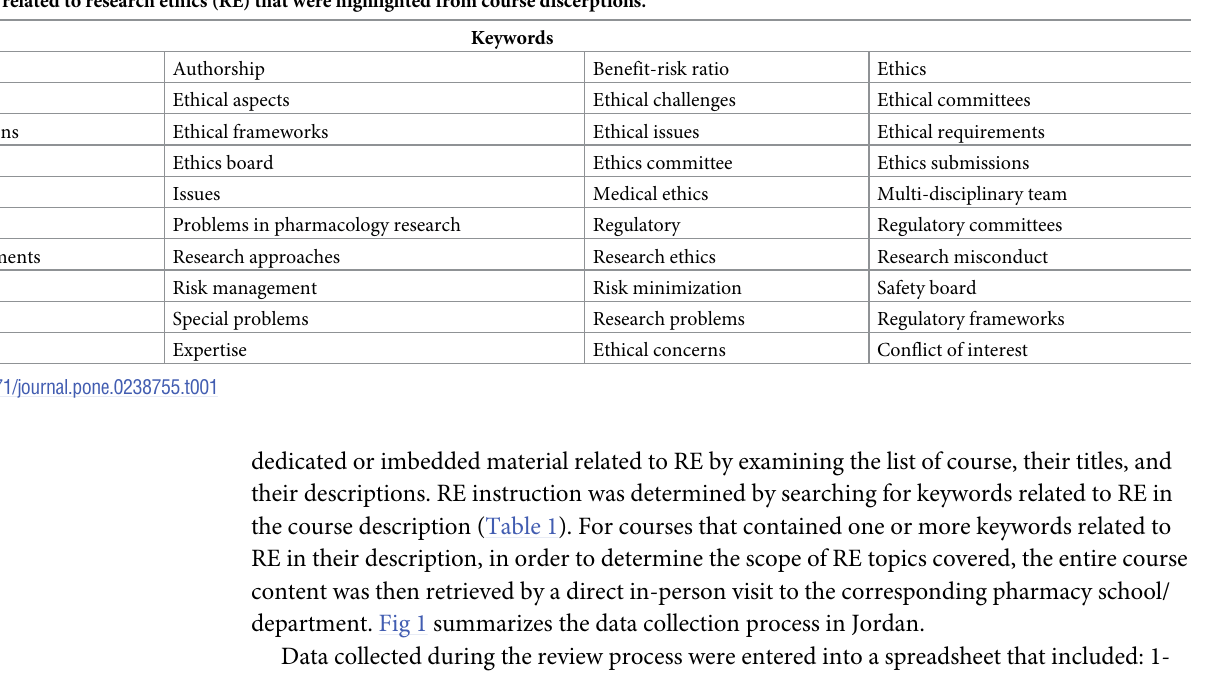
Table 1. Keywords related to research ethics (RE) that were highlighted from course